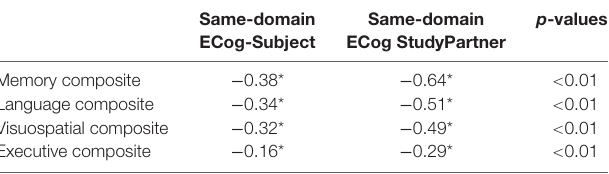
TABLE 4 | Comparison of correlation coefficients between subjective and objective measures of cognitive